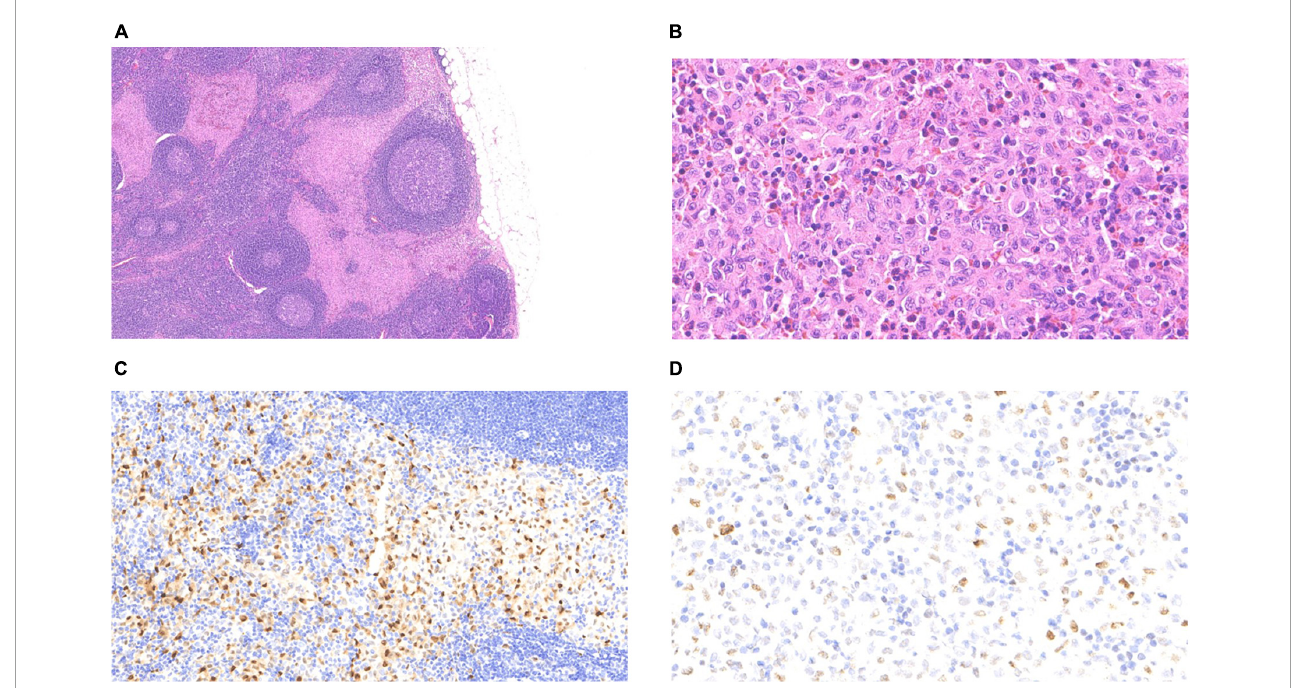
FIGURE3 Langerhans cell histiocytosis of the lymph nodes: (A) The pink-stained area at the subcapsular sinus was that of LCH (4 × ). (B) LCH cells were diffusely distributed with eosinophils (40 × ). (C) Nuclear positivity for cyclin D1 (20 × ). (D) Variable nuclear positivity for p53 (40 ×